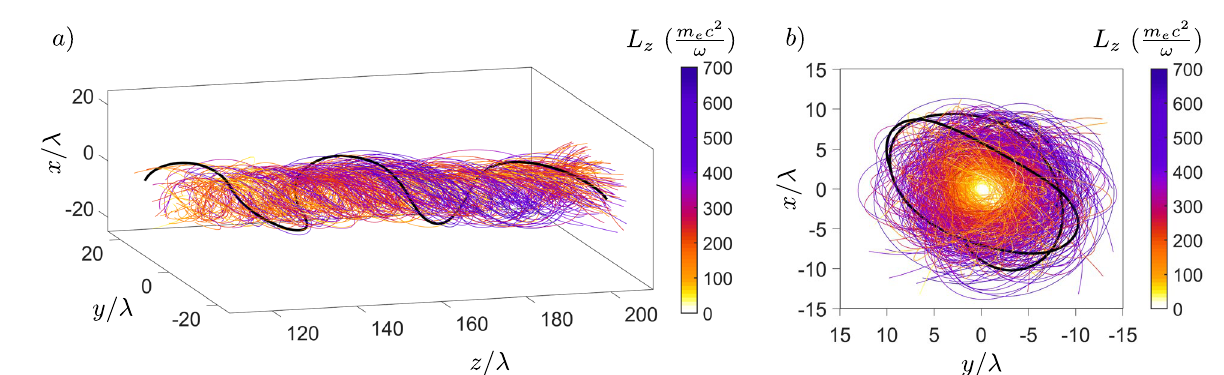
0 (black), 4 (red), 8 (blue) . ( b ) Axial magnetic =